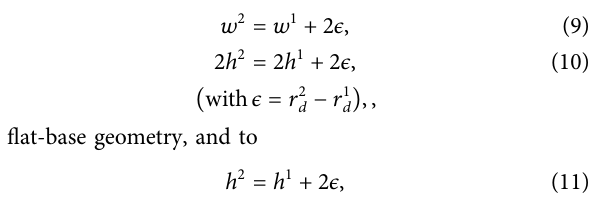
Frontiers in Chemistry |